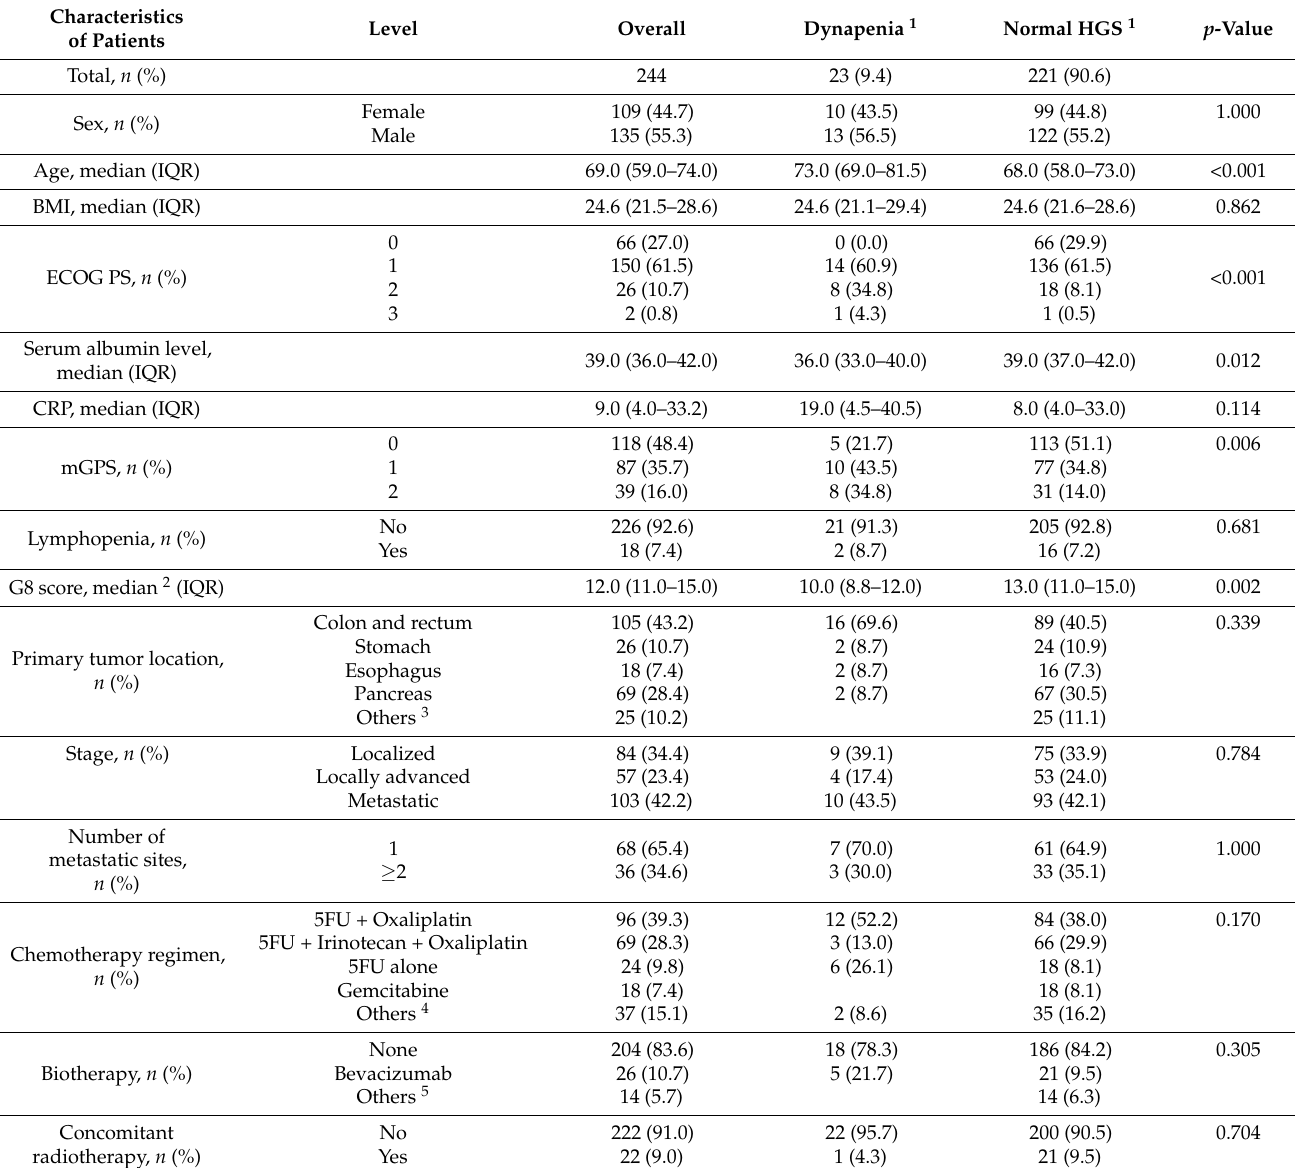
Table 1. Overall population characteristics and according to dynapenia (EWGSOP2